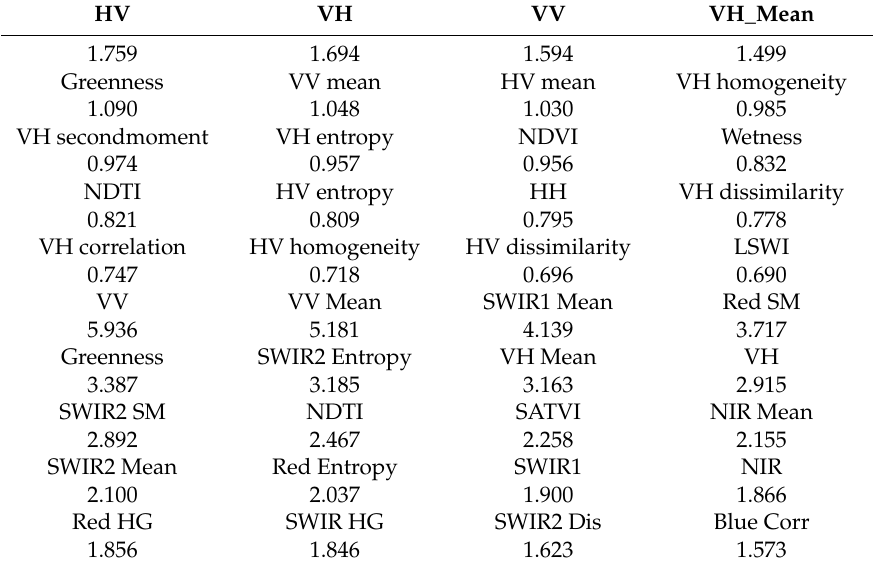
Table 2. Top Gini index values for (top) West Kalaimantan and (bottom) Tanintharyi using combined Landsat 8, PALSAR-2, and Sentinel-1.